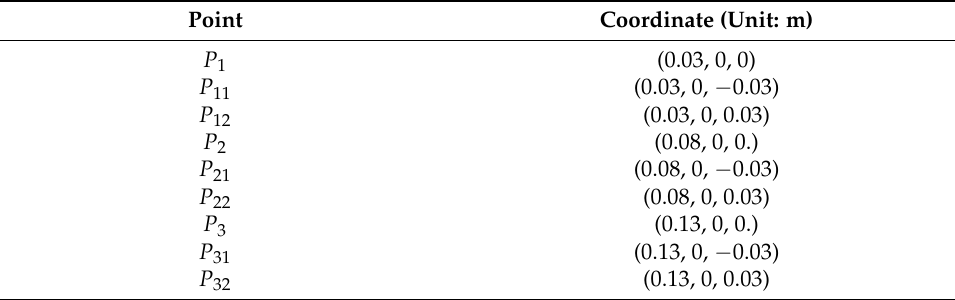
Table 4. Coordinates of points when the FLS is not